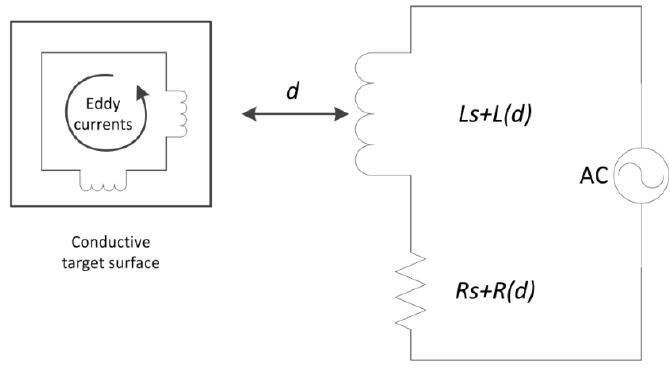
Figure 2. Inductive sensing principle.